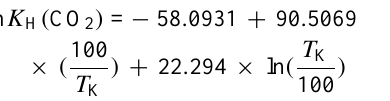
Fig. 3. Schematic representation of estimated annual emissions based on seasonal field surveys for CO 2 -supersaturated systems. Dotted line represents partial pressure of CO 2 at water surface in equilibrium with atmosphere.